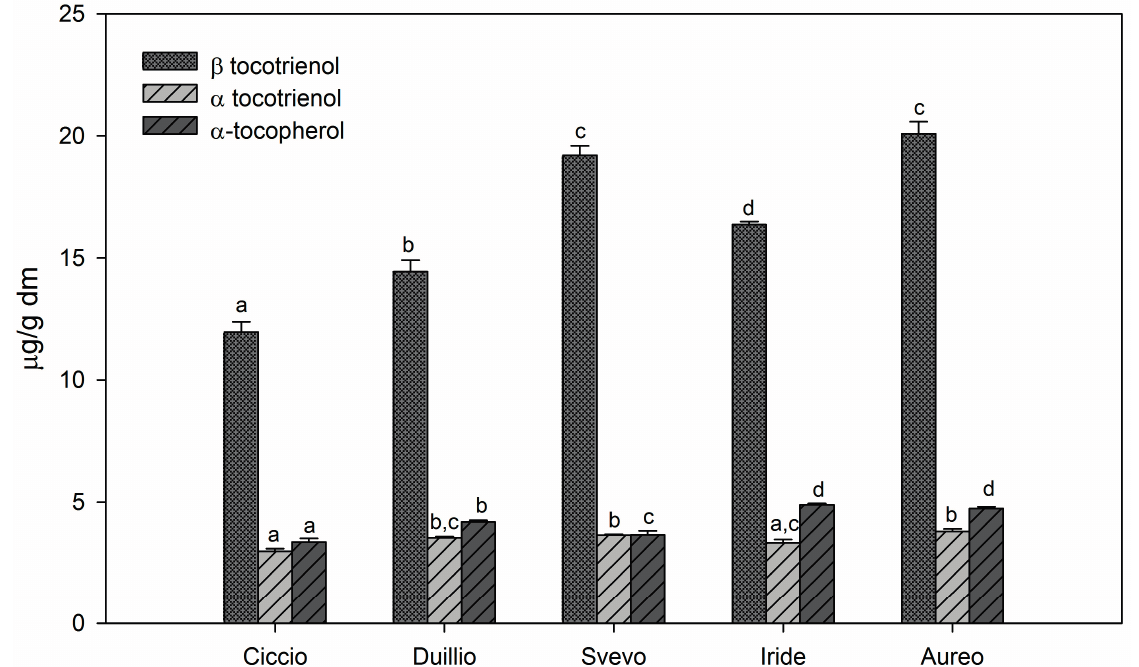
Figure 3. Content of tocols, expressed as μ g/g dm, in the whole meal flour of five, Italian, durum wheat cultivars. Different letters, within each histogram series, indicate significant differences between different samples ( n = 3, p <